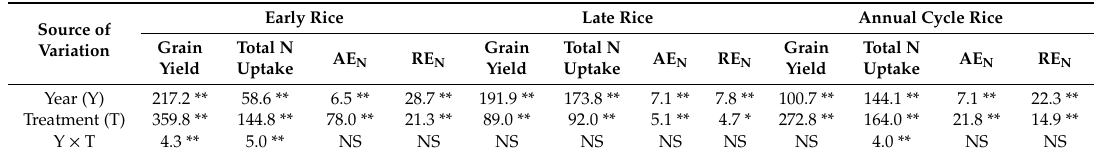
Table 1. Analysis of variance ( F values) for grain yield, total N uptake, agronomic N use e ffi ciency (AE N ), and fertilizer N recovery e ffi ciency (RE N ) of the early rice, late rice, and annual cycle rice in 2015, 2016, and 2017 in Huarong County.